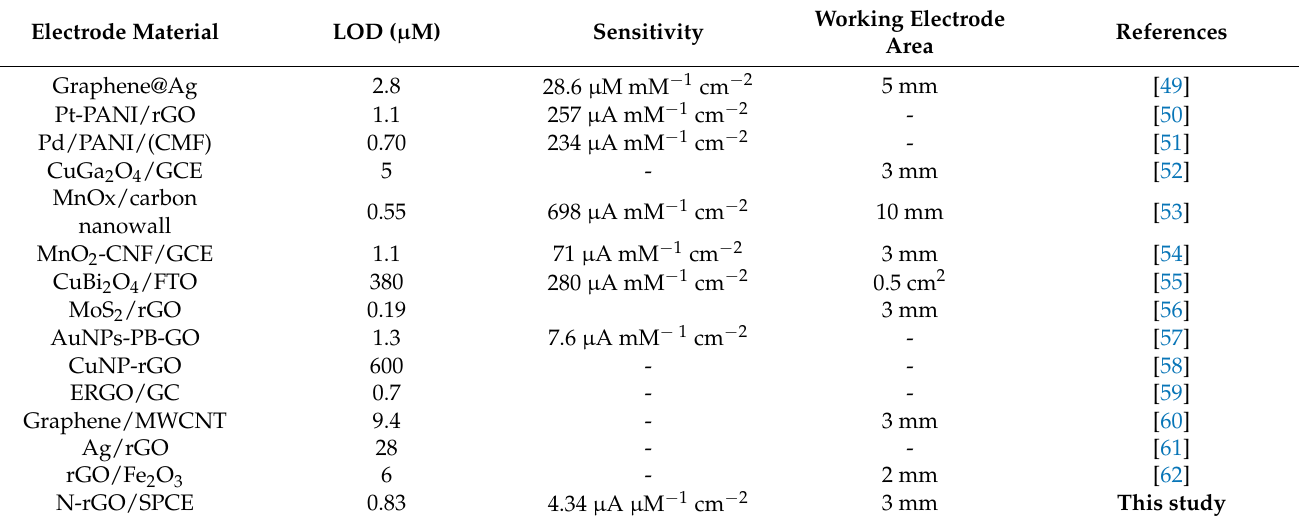
Table 1. The comparisons of the LOD and sensitivity with previous